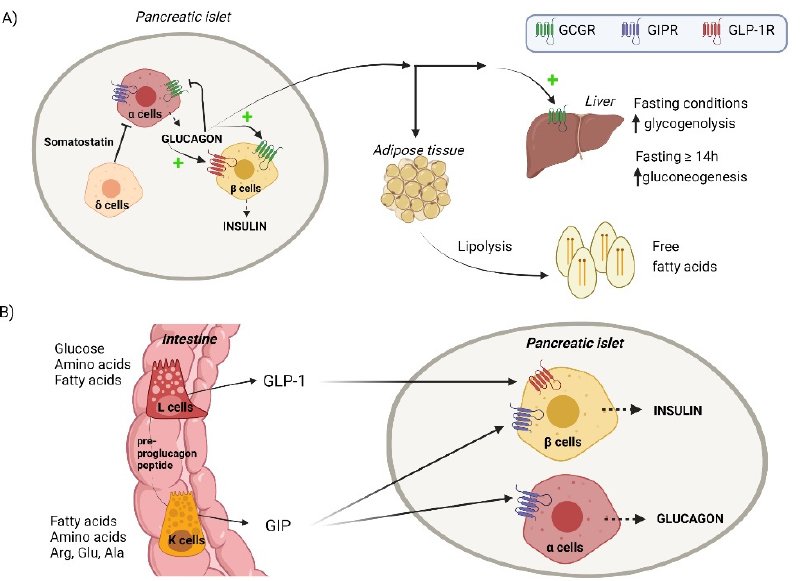
Figure 1. Main actions of glucagon, GLP-1, and GIP hormones. ( A ) In fasting conditions, α cells produce glucagon. In the liver, glucagon through GCGR activates the main regulated metabolic enzymes of glycogenolysis within the first hours of fasting and gluconeogenesis in fasting periods longer than 14 h. In β cells, glucagon also signals through GCGR and GLP-1R and stimulates insulin release which will promote the internalization of the hepatic glucose produced during fasting by periphery tissues. Glucagon production is inhibited by β and δ cell-derived factors like insulin and somatostatin, respectively, and by itself through a negative feedback loop. ( B ) The incretin hormones GLP-1 and GIP are secreted by the L and K cells of the intestine, respectively, in response to feeding and have insulinotropic actions through their respective receptors in β cells. While GLP-1 production is induced by glucose, fatty acids, proteins, and amino acids, the release of GIP is mostly induced by dietary fat and amino acids, especially arginine, glutamine, and alanine. GIP also displays a glucanotropic action through GIPR in α cells which explains the postprandial rise of glucagon after an amino acid-rich meal. Created with BioRender.com.